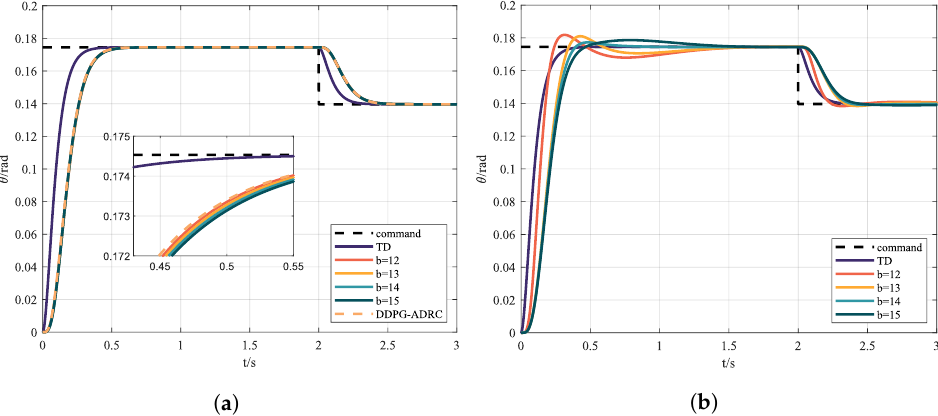
Figure 8. ( a ) Control instruction and state response via ADRC with different b and ( b ) control instruction and state response via MPC with different b . Table 2. Evaluation indicators of MPC, traditional ADRC, and